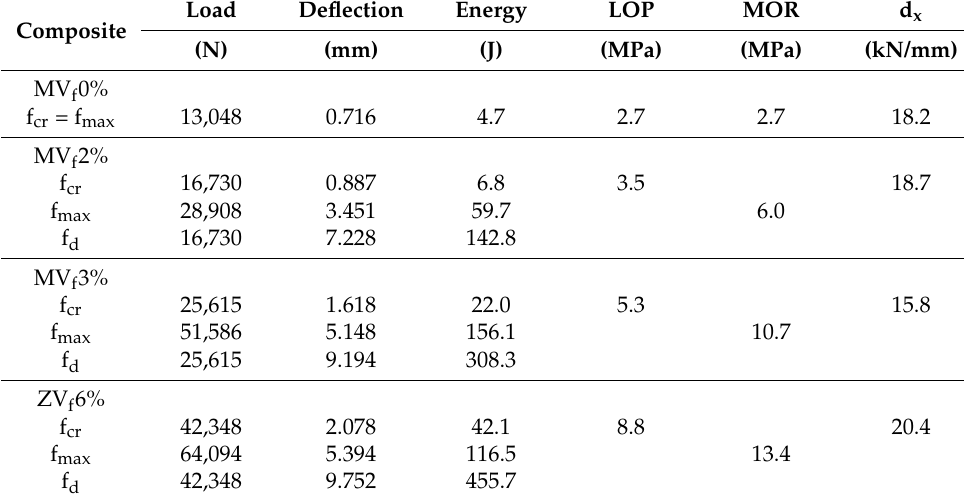
Table 2. Tested specimens, a compilation of data in relation to characteristic points f x